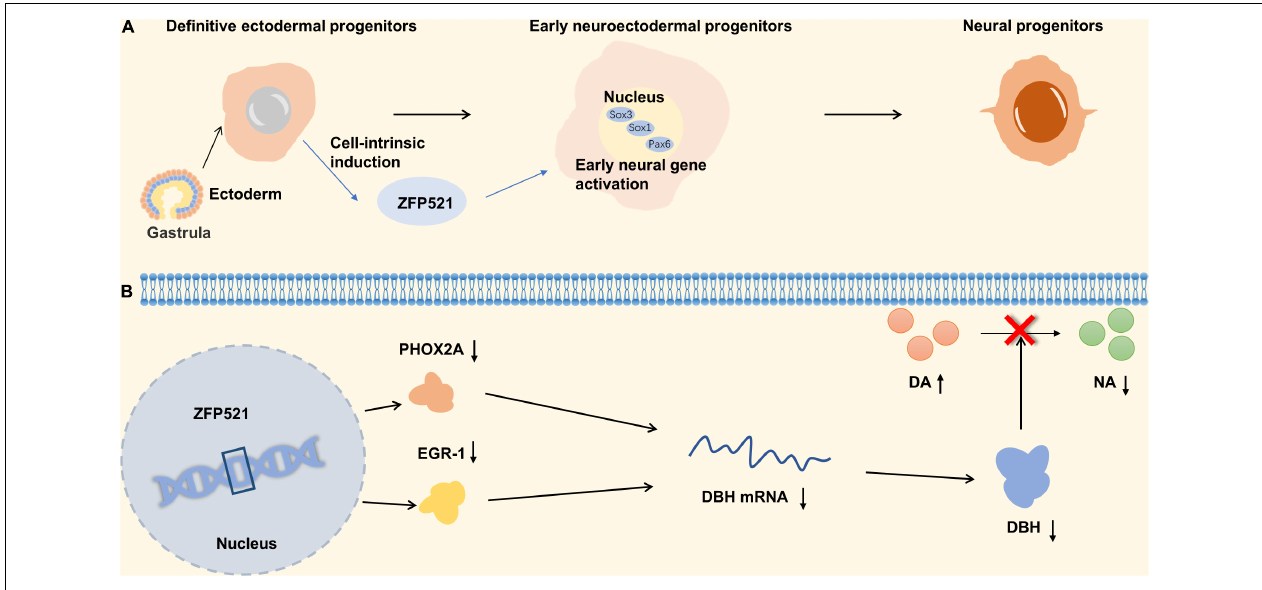
FIGURE 4 | Zinc finger proteins (ZNF) associated with schizophrenia. (A) The relationship between ZNF521 and the differentiation of neural progenitors. (B) The mechanism of ZNF521 in schizophrenia.